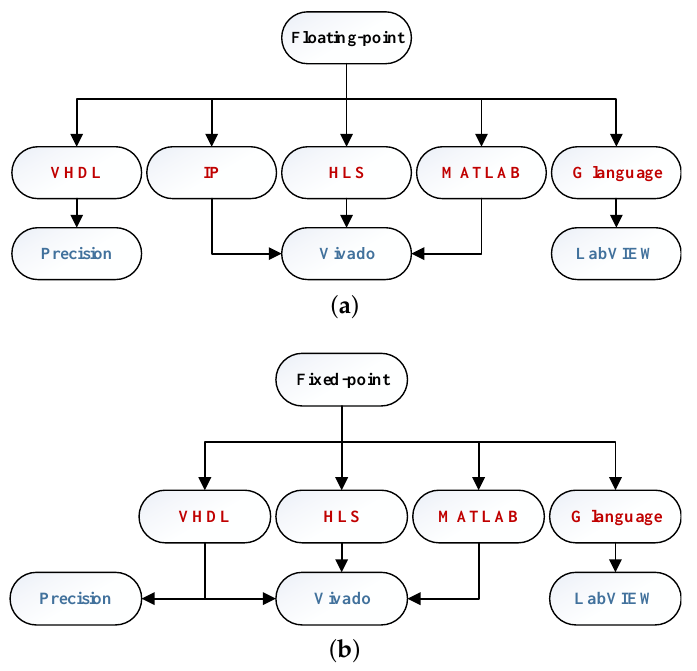
Figure 3. Design alternatives; ( a ) Floating-point design possibilities, ( b ) Fixed-point design